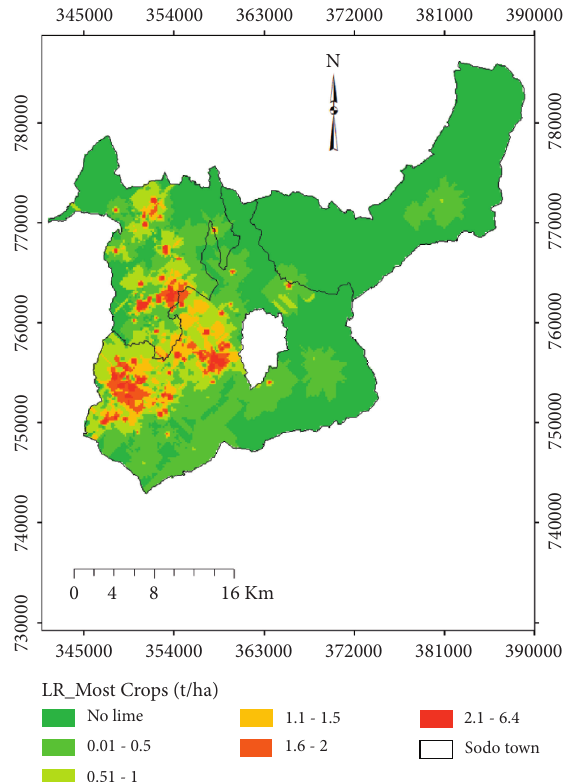
Figure 9: Extent and spatial distribution of lime requirement (t/ha) for most annual crops production across the study